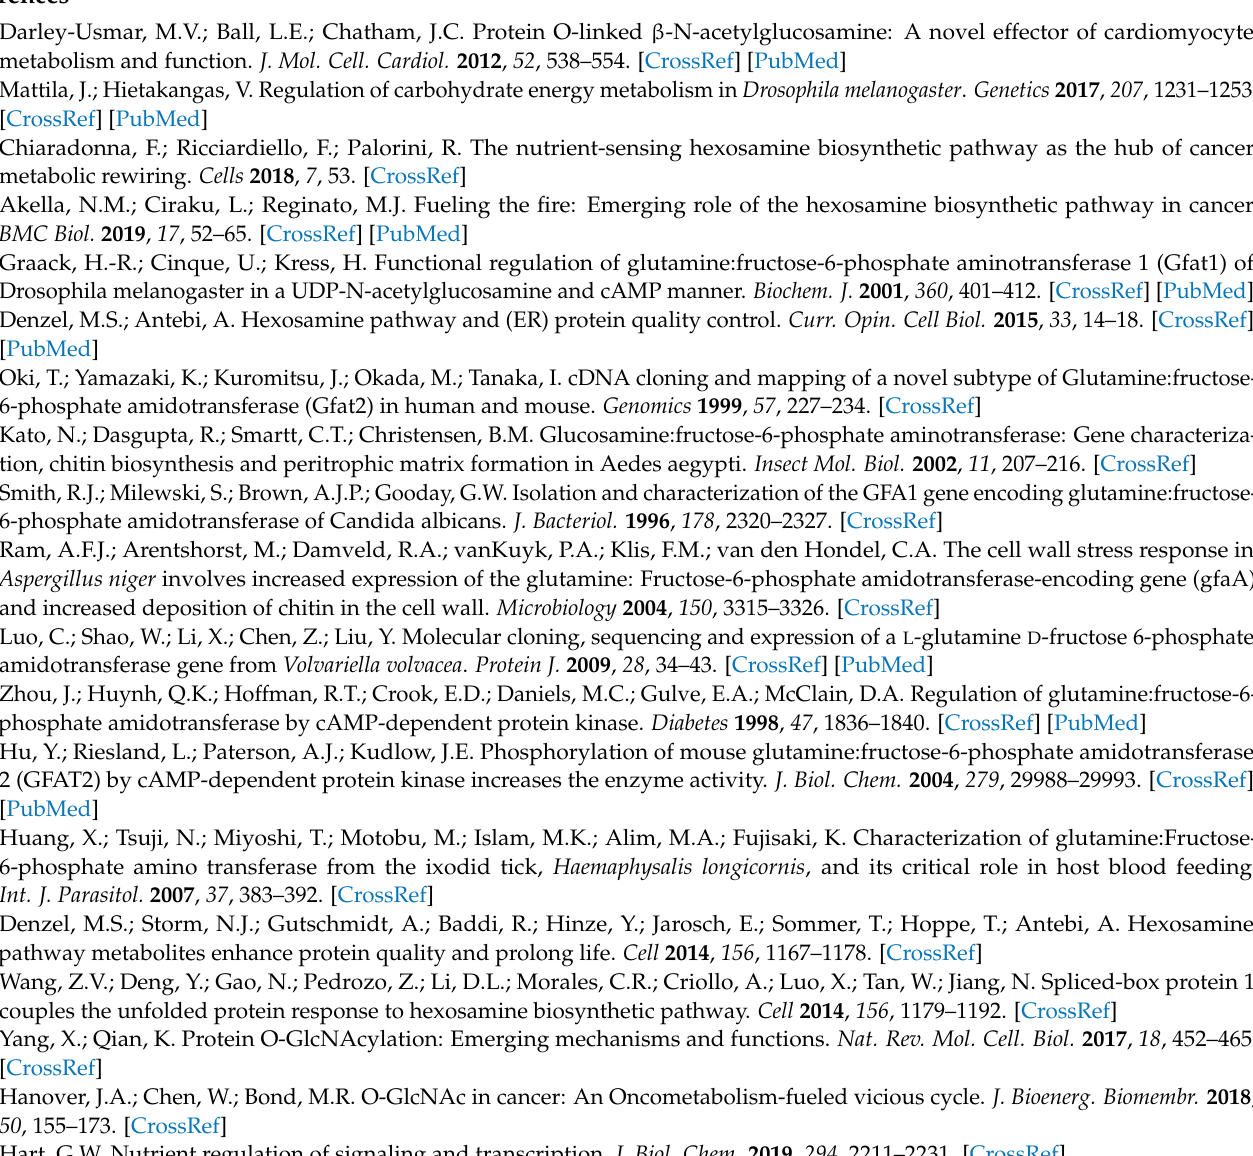
zep alleles; Table S4. qPCR primer sequences; Table S5. Microsynteny of two genes flanking RpL15 or its orthologue in six Drosophila